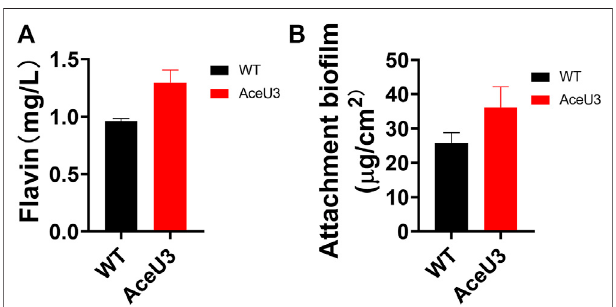
FIGURE 5 | Biochemical analyses of the engineered S. oneidensis and WT. (A) Determination of fl avin concentration in the anolytes of MFCs, and (B) the attached biomass of each strain on anode surfaces. All error bars were calculated from triplicate